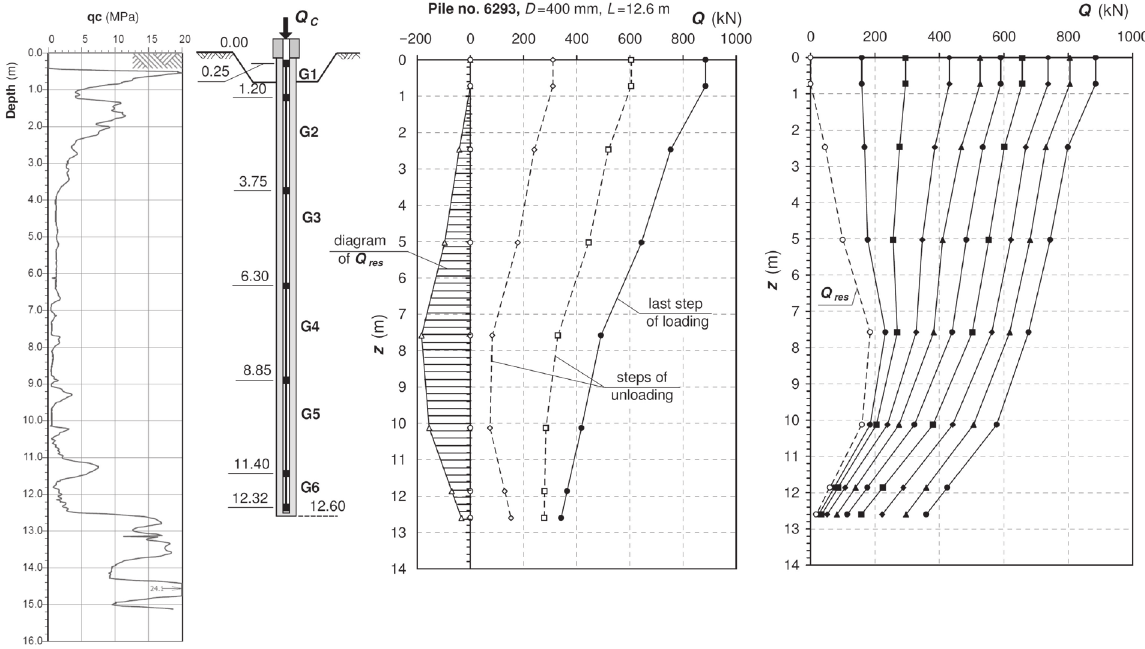
Figure 8: Pile no. 6293: (a) determination of the residual force in the pile shaft and (b) its inclusion in the distribution of the axial force along the pile in successive load